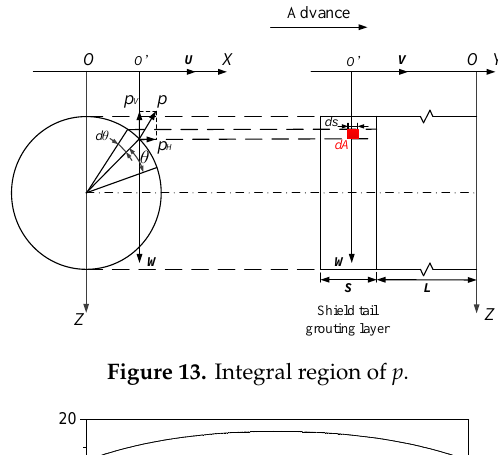
( b ) Figure 12. Ground movements caused by f s : ( a ) Settlement; ( b ) Horizontal displacement.